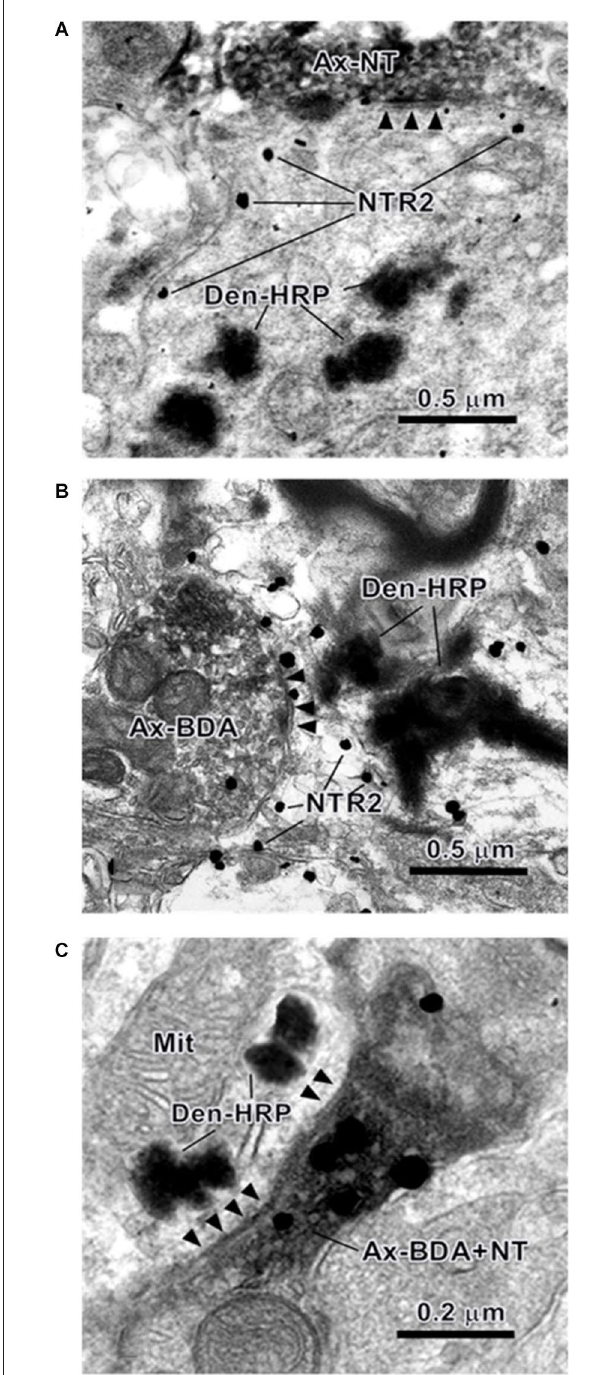
FIGURE 5 | Electron photomicrographs showing the synaptic connections in the RVM revealed using the triple-labeling method . An NT-IR axon terminal (Ax-NT) (A) or a BDA-labeled axon terminal (Ax-BDA) (B) synapses on a dendrite that is retrogradely labeled with HRP (Den-HRP) and immunopositively stained for NTR2. The synaptic contact between an NT/BDA double-labeled axon terminal (Ax-BDA+NT) and an HRP-labeled dendritic profile (Den-HRP) is also shown (C) . The arrowheads indicate the post-synaptic membranes. Mit: mitochondria.